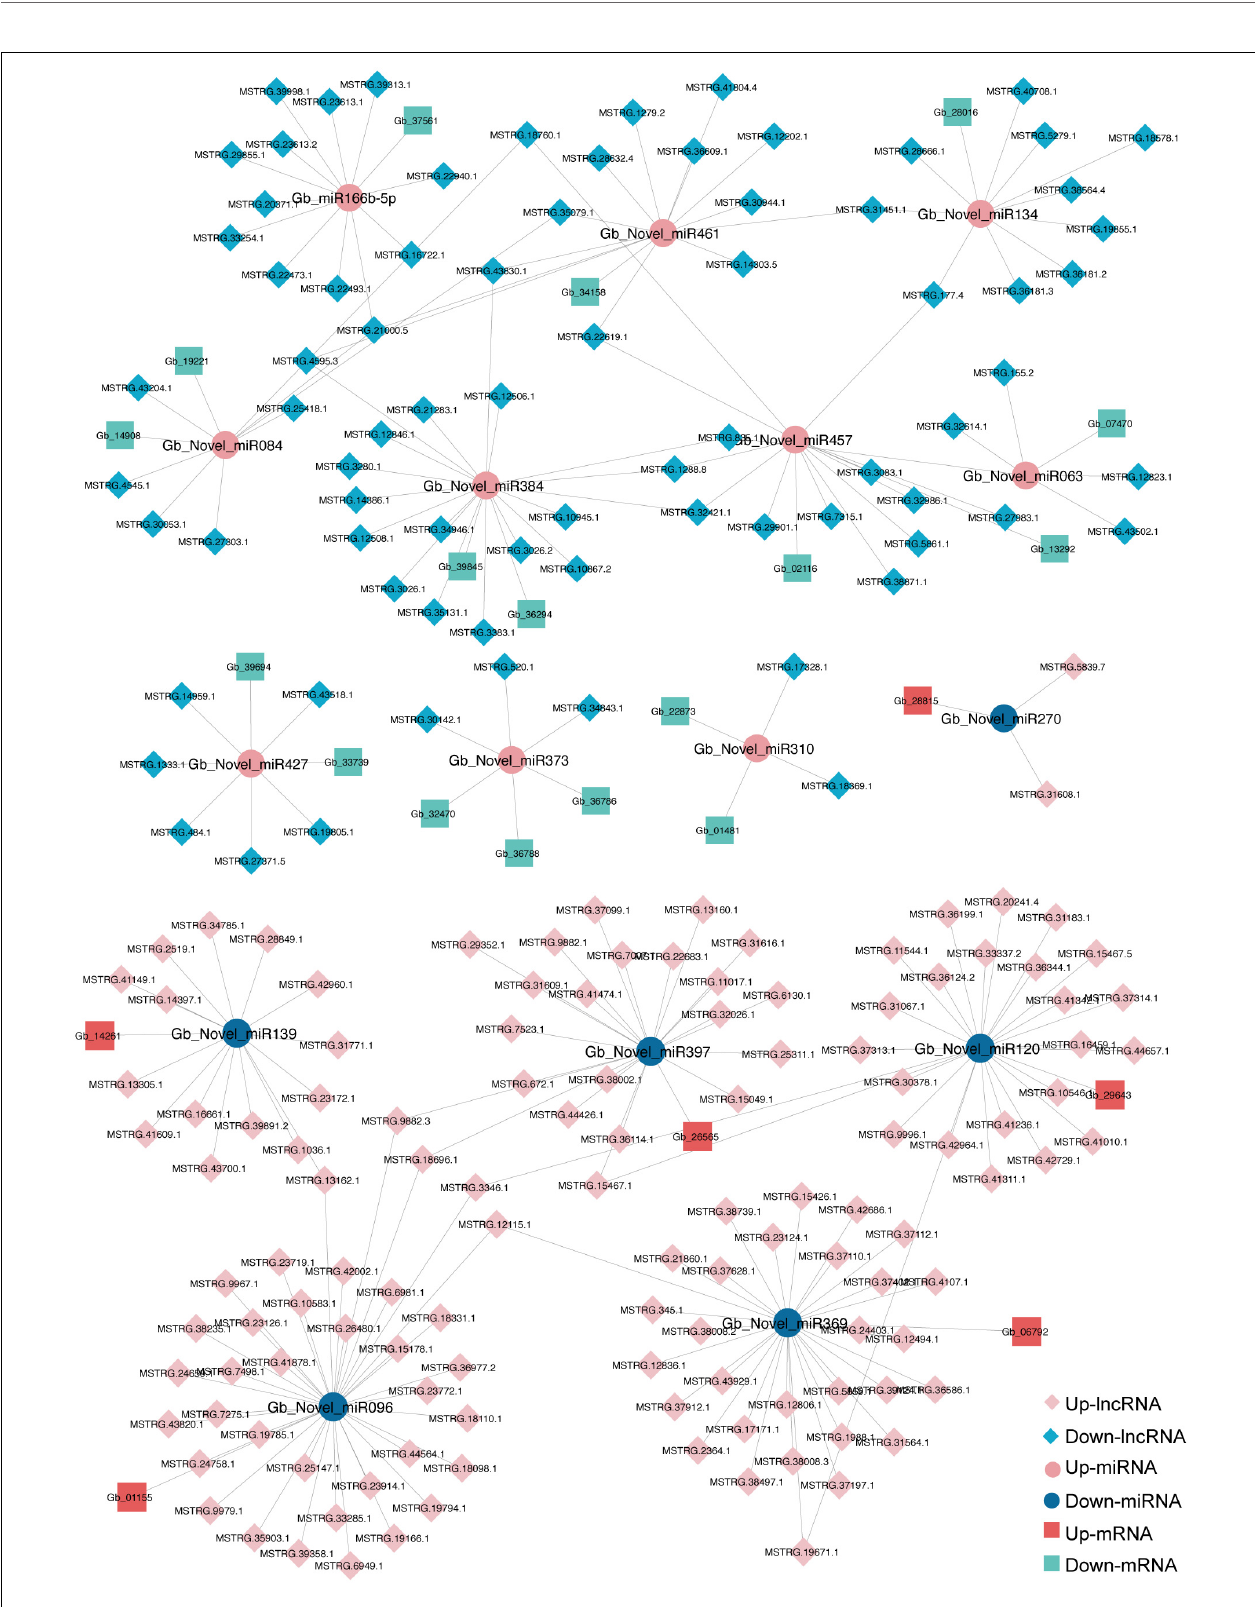
FIGURE 8 | A sub-competing endogenous RNA (ceRNA) network is involved in GO term of response to water between the early (ST3-1) and the late (ST3-2) exuberant differentiation stages in ginkgo.